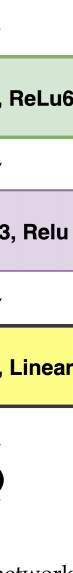
Figure 7. Mobile network with an MBConvolution block composed of three convolutional layers and a linear